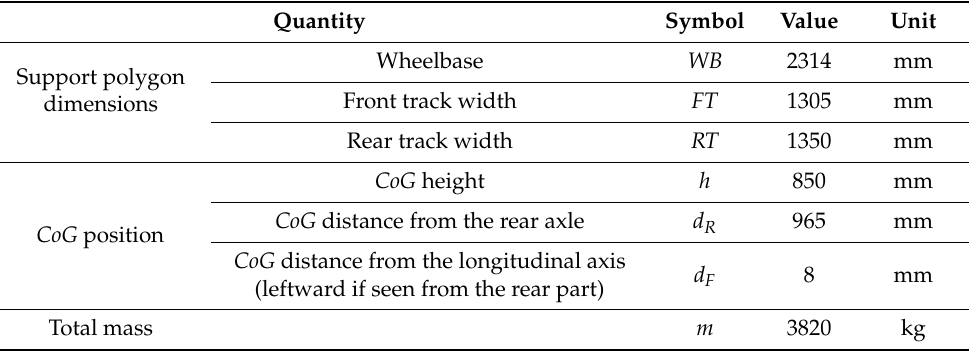
Table 2. Main technical characteristics of a “New Holland TL 90 4WD” farm tractor.